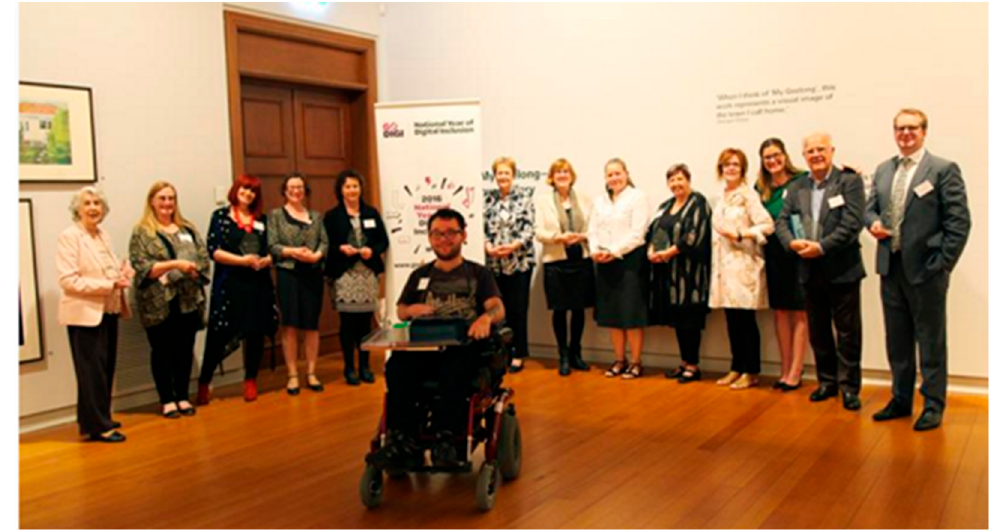
Figure 2. National Year of Digital Inclusion Award Recipients, including JB (pictured at front, seated in a powered wheelchair). Source: https://www.godigi.org.au/blog/congratulations-our-national- year-digital-inclusion-award-recipients (accessed on 12 January 2022).